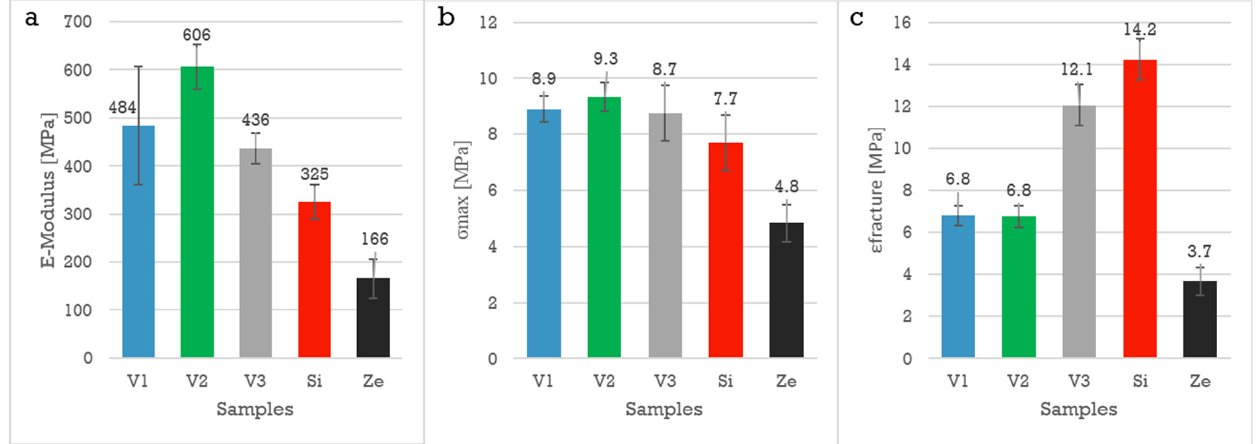
Figure 7. Young’s moduli ( a ), ultimate tensile strength ( b ), elongation at break ( c ) of the V1, V2, V3, Si (SiCeram), Ze (Zetamix) printed green-body tensile specimens.